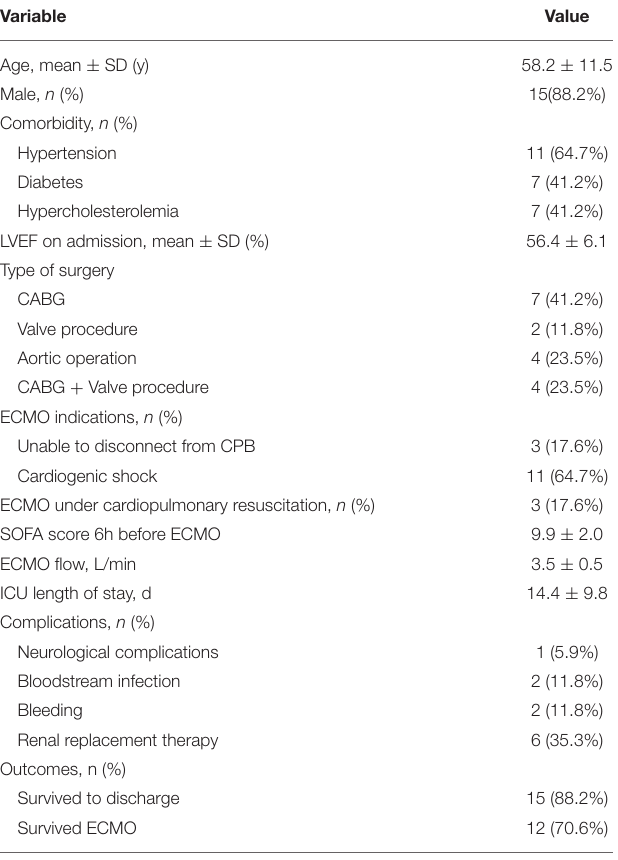
TABLE 1 | Characteristics of the 17 patients.